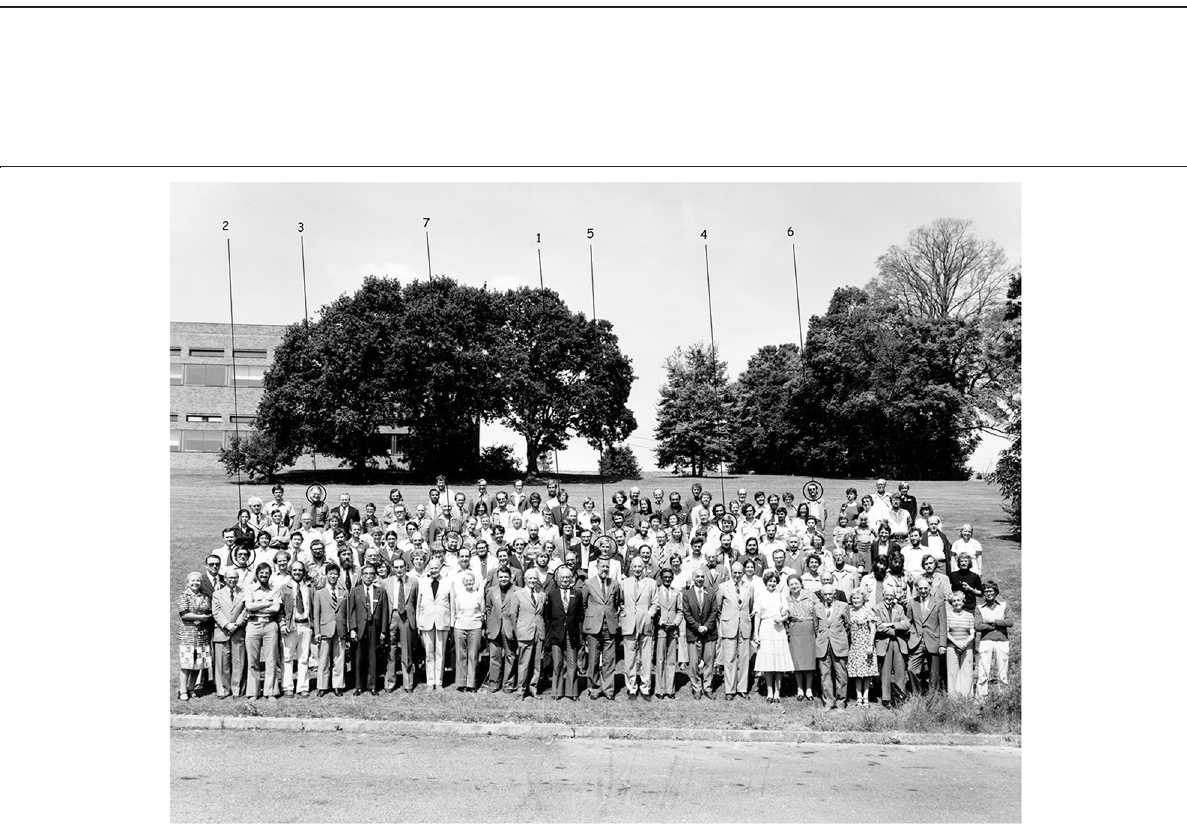
Figure 3 Official photo of the VII International Congress of Arachnology which took place in Exeter (UK) in 1977. A number of scorpiologists were present: (1) M. Vachon, (2) B. Lamoral, (3) J. L. Cloudsley-Thompson, (4) N. F. Hadley, (5) H. W. C. Couzijn, (6) W. R. Lourenço, (7) M. R.